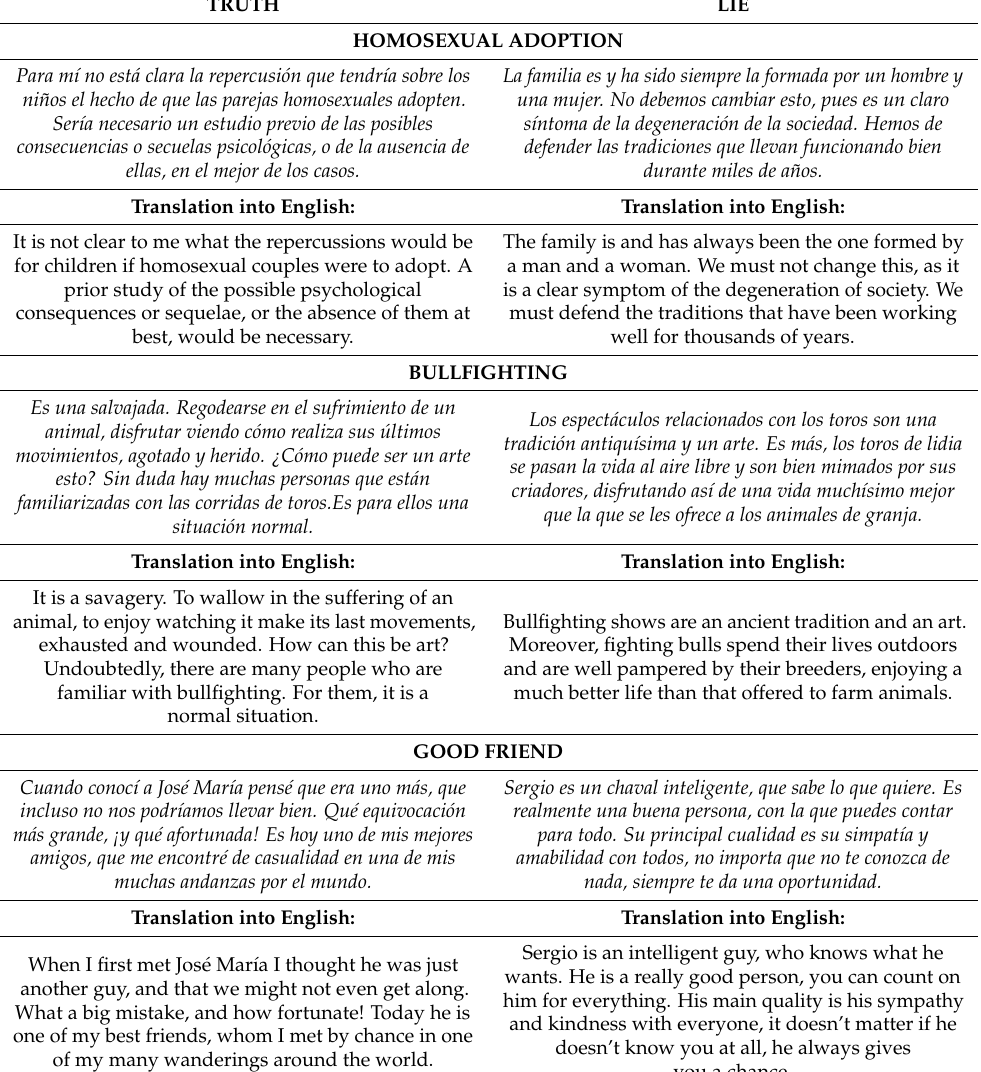
Table A3. Random sample 1 of truthful and untruthful statements in Spanish.